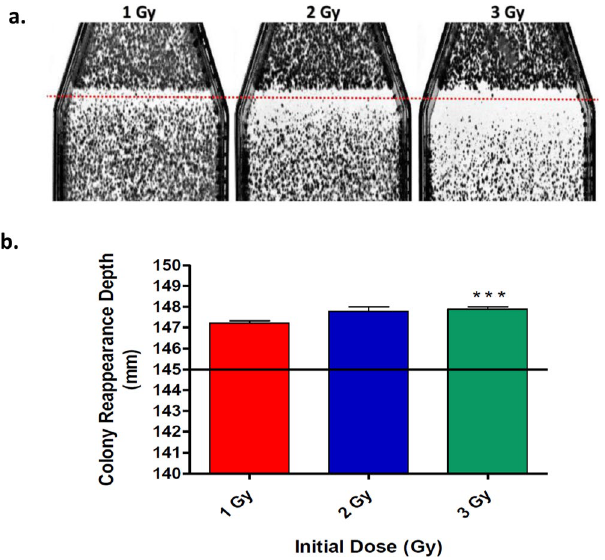
Figure 4. Reappearance of colony formation following biological Bragg peak. ( a ) Close up image of flasks in Fig. 1c following irradiation of carbon-ion beam at increasing dosages displaying the increased lethal dose range with an increased initial dosage. Dotted red line represents biological Bragg peak depth at 14.5 cm. ( b ) Colony reformation under all initial dosage treatments between depths of 14.7–14.8 cm. Increase of initial dosage led to significant increase in depth of colony reappearance ( P = 0 . 0496 ). Colony reappearance depth of 3 Gy was significantly increased as compared to 1 Gy ( P < 0 . 05 ), Dunnett’s Multiple Comparison Test. Straight line representative of our biological Bragg peak. Error bars indicate standard errors of the means from as many as three independent experiments per each initial